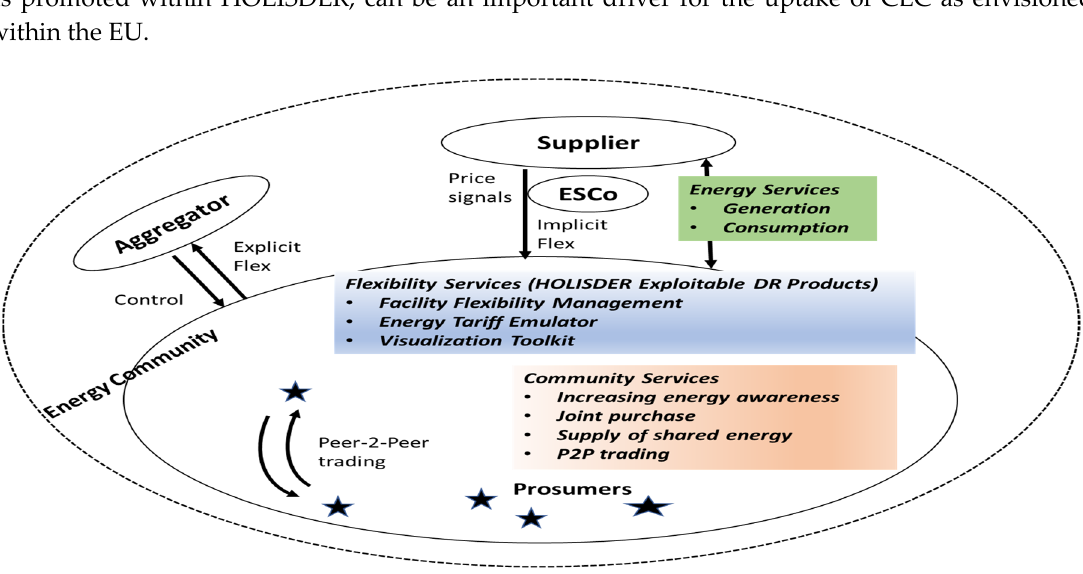
Figure 1. Overview of services related to Energy Communities: Community Services offered to its own members (prosumers), Energy services and stacking Flexibility services that Energy parties can offer to the community as a whole. The dashed contour illustrates the situation where the energy community takes on the roles of the energy parties itself (Figure is adapted from